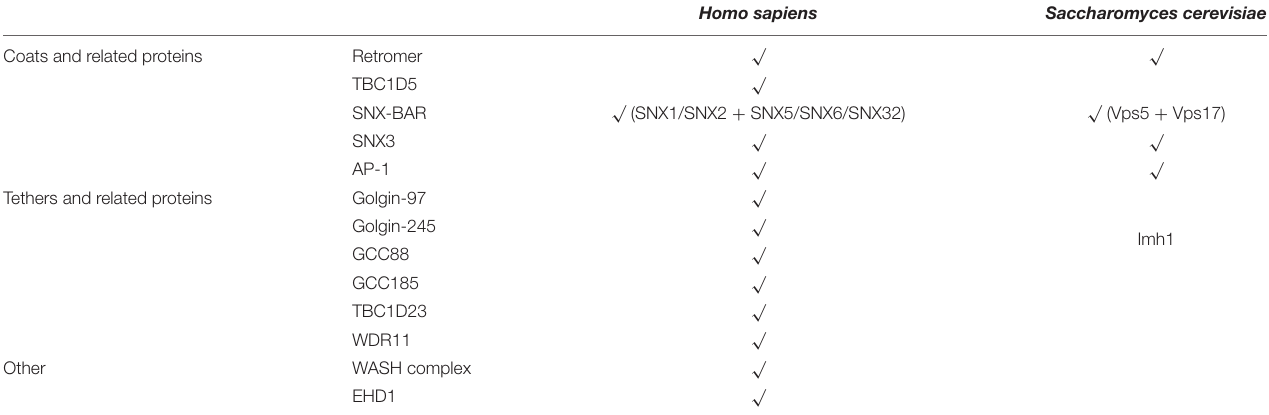
Homo sapiens Saccharomyces cerevisiae